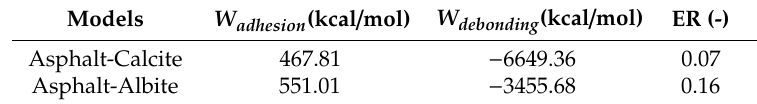
Table 2. Energy ratio (ER) calculation for di ff erent models.